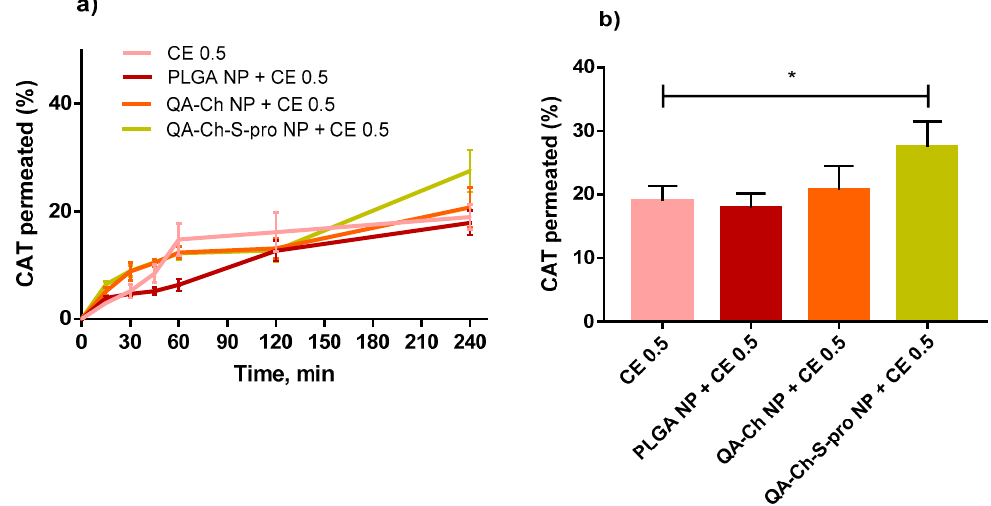
Figure 5. Comparison between PLGA NPs and Ch-derivative (QA-Ch and QA-Ch-S-pro) NPs loaded with CE for CE permeation properties. ( a ) represents % CAT permeated from non-encapsulated CE or CE-loaded NPs at the CE concentration of 0.5 µg/mL GAE, over time. ( b ) represents the % CAT contained in CE 0.5 µg/mL GAE, permeated after 240 min. *, significantly different from each other. 2.5. Protective Effect of Non-Encapsulated CE or NP-Loaded CE from Oxidative Stress Before studying the protective effect of empty PLGA NPs or CE, free or encapsulated in PLGA NPs, from oxidative stress, their cytotoxicity on HUVECs following two hours of incubation was evaluated. The relevant values for increasing concentrations of empty PLGA NPs in the 0.6–12 mg/mL, reported in Figure 6a, show the absence of any toxicity of the concentrations tested. These concentrations are exactly the same as those of the CE-loaded PLGA NPs, the relevant data of which are shown in Figure 6b. In this figure, it is also shown that CEs, whether free or encapsulated in PLGA NPs, are not toxic on HUVECs at any of the concentrations tested. Therefore, the protection effect from oxidative stress was evaluated at all concentrations tested, as reported in Figure 6a,b. Data for the ability of empty PLGA NPs or CE either free or encapsulated in PLGA NPs to protect HUVECs from oxidative stress induced by H 2 O 2 are found in Figure 7a,b. The H 2 O 2 toxic effect on HUVECs is demonstrated by a reduction in cell viability until about 30%. Data reported in Figure 7a show that no protective antioxidant effect is exerted by 2-h pre-treatment of HUVECs with empty PLGA NPs. Instead, data in Figure 7b show that non-encapsulated CEs exert a significant effect against HUVEC oxidation at 5 and 10 µg GAE/mL concentrations. The same effect is observed with HUVEC pre- treated for 2 h with CE encapsulated in PLGA NPs at 5 or 10 µg GAE/mL. Data indicate that the CEs encapsulated in PLGA NPs maintain their antioxidant activity. Figure 7b also shows the results obtained in our previous work [10] with CE encapsulated in QA-Ch NPs and QA-Ch-S-pro NPs. In the figure, the ability of CE encapsulated in QA-Ch-S-pro NPs to protect the HUVECs from oxidative stress is seen even at the CE concentration of 2 µg GAE/mL, which was ineffective with the CE either free or encapsulated in PLGA NPs. This result can be ascribed to a synergistic antioxidant effect of CE and the protected pendant SH groups on the surface of the QA-Ch-S-pro NPs that were not present on the QA-Ch NP surface. The latter were indeed unable to protect HUVECs from oxidative stress. In fact, the protected thiols are known to act as strong reducing groups [31]. The enzyme protein disulfide isomerase catalyzes the formation or rupture of disulfide bonds, i.e., redox reactions where thiol is in the reduced (and reductive) form.